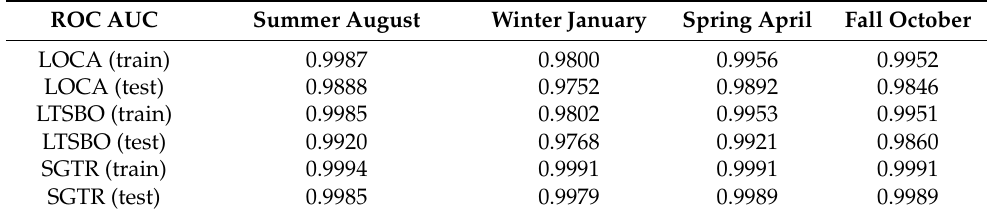
Table 4. ROC AUC of the three accidents in the four models